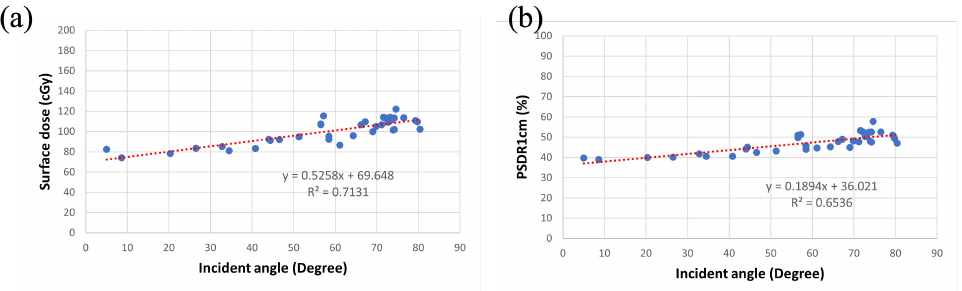
Figure 8. The relationship between surface dose, PSDR1cm and incident angle in both directions. Both the trendlines (red dashed lines) are under linear regression. ( a ) is the surface dose vs. the incident angle and ( b ) is PSDR1cm vs. the incident